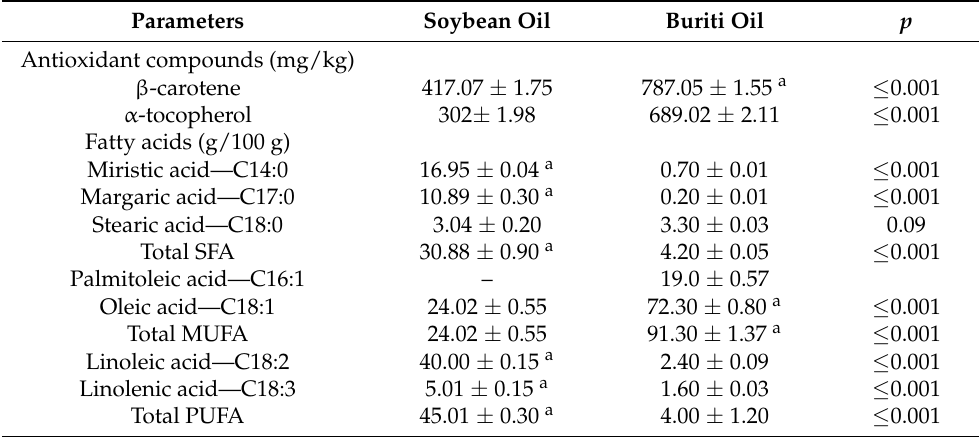
Table 1. Fatty acids, β -carotene, and α -tocopherol contents in buriti and soybean oils. Parameters